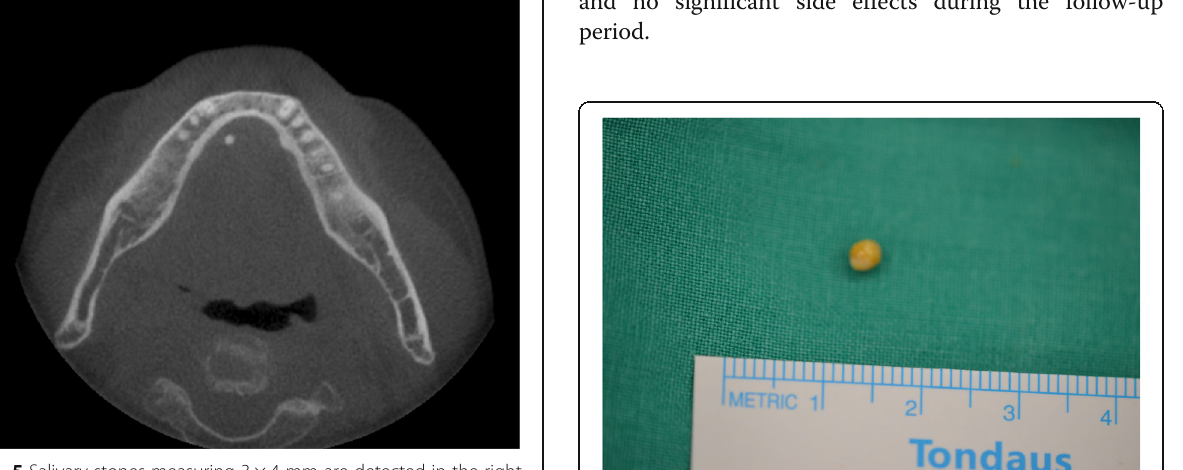
Fig. 5 Salivary stones measuring 3 × 4 mm are detected in the right submandibular gland with cone-beam